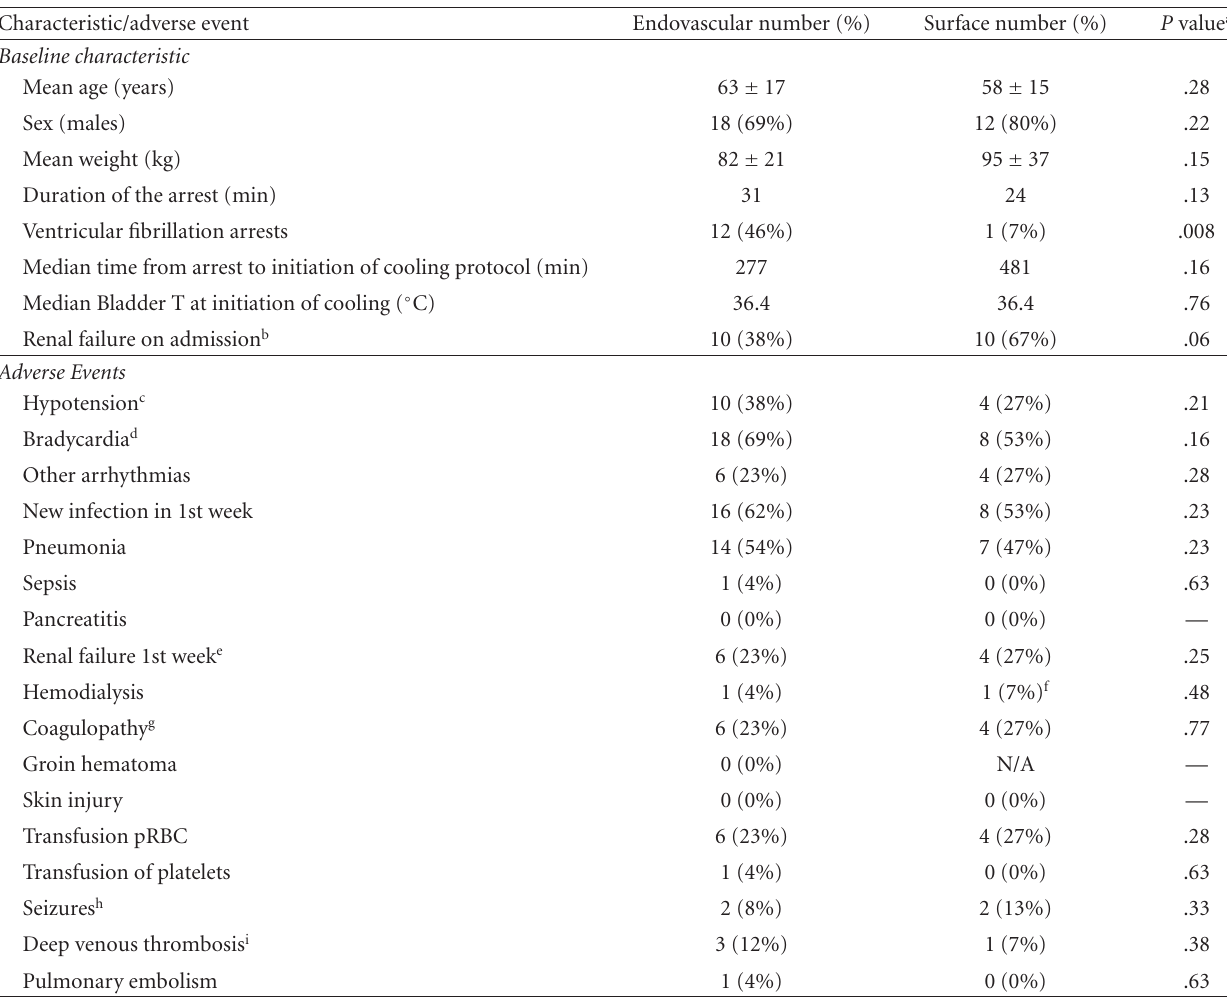
Table 1: Baseline characteristics and adverse events during the first week in the endovascular-( N = 26) and surface-cooled groups ( N = 15). Characteristic/adverse event Endovascular number